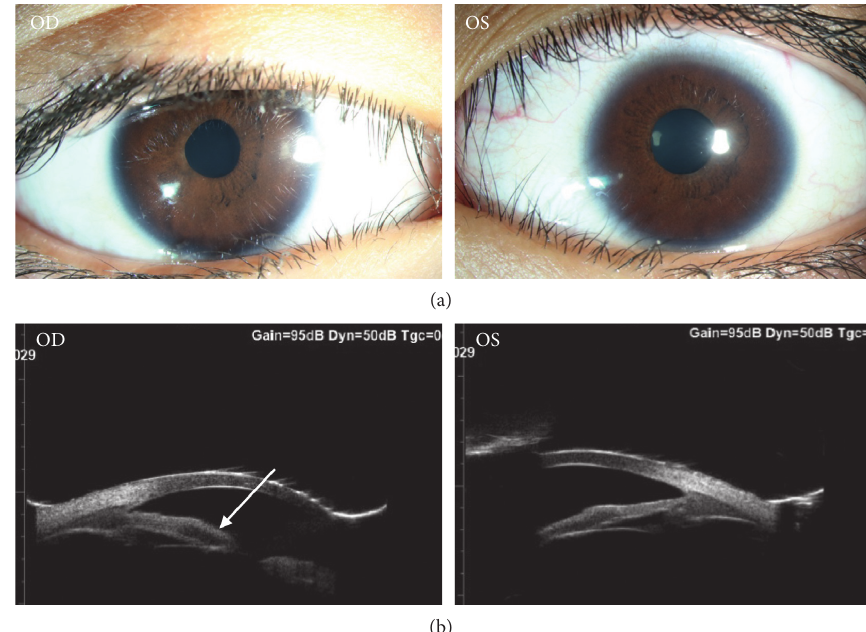
Figure 1: Images of the ocular anterior segment. (a) Bilateral pupils were irregular in shape, a poor light reaction, and no response to any available mydriatic agents. (b) UBM showed remarkable hyporeflection in the iris in right eyes (arrow). Anterior chamber angle was wide- open under the gonioscope. OD, right eye; OS, left